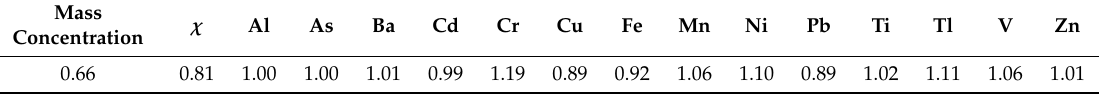
Table 4. Ratios of measured features between PM1 and TSP.